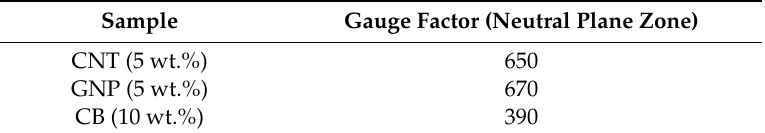
Table 2. Sensitivity values (gauge factor) of in-line nanostructured fibres in a linear range (up to 1% neutral plane zone during a quasi-static 3-point bending test; the gauge factor is the ratio of relative change in electrical surface resistance ( ∆ R / R ) to the mechanical strain ( ∆ l / l ).